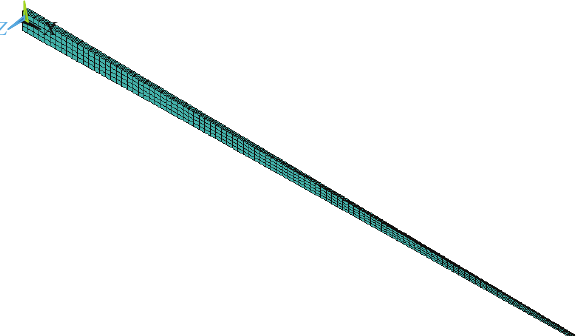
Figure 5: FEM model for homogenous tapered beams by using